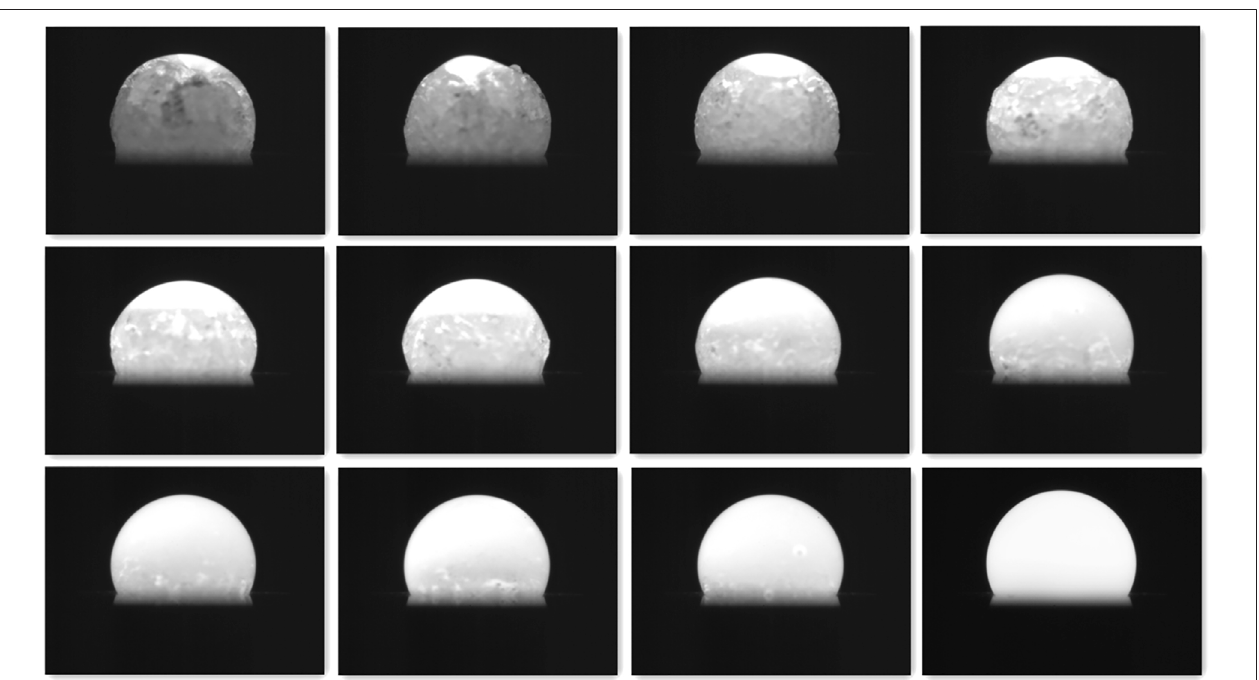
FIGURE 4 | Melting process of the alumina sample heated by the upper laser. Lower part of the sample is hidden by the conical nozzle.